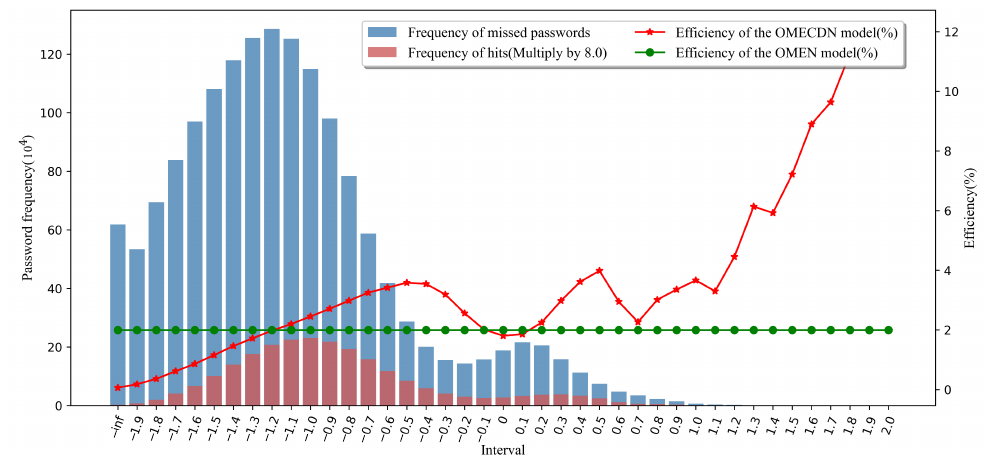
Figure 10. The distribution of 1 × 10 7 passwords scores generated by the OMECDN